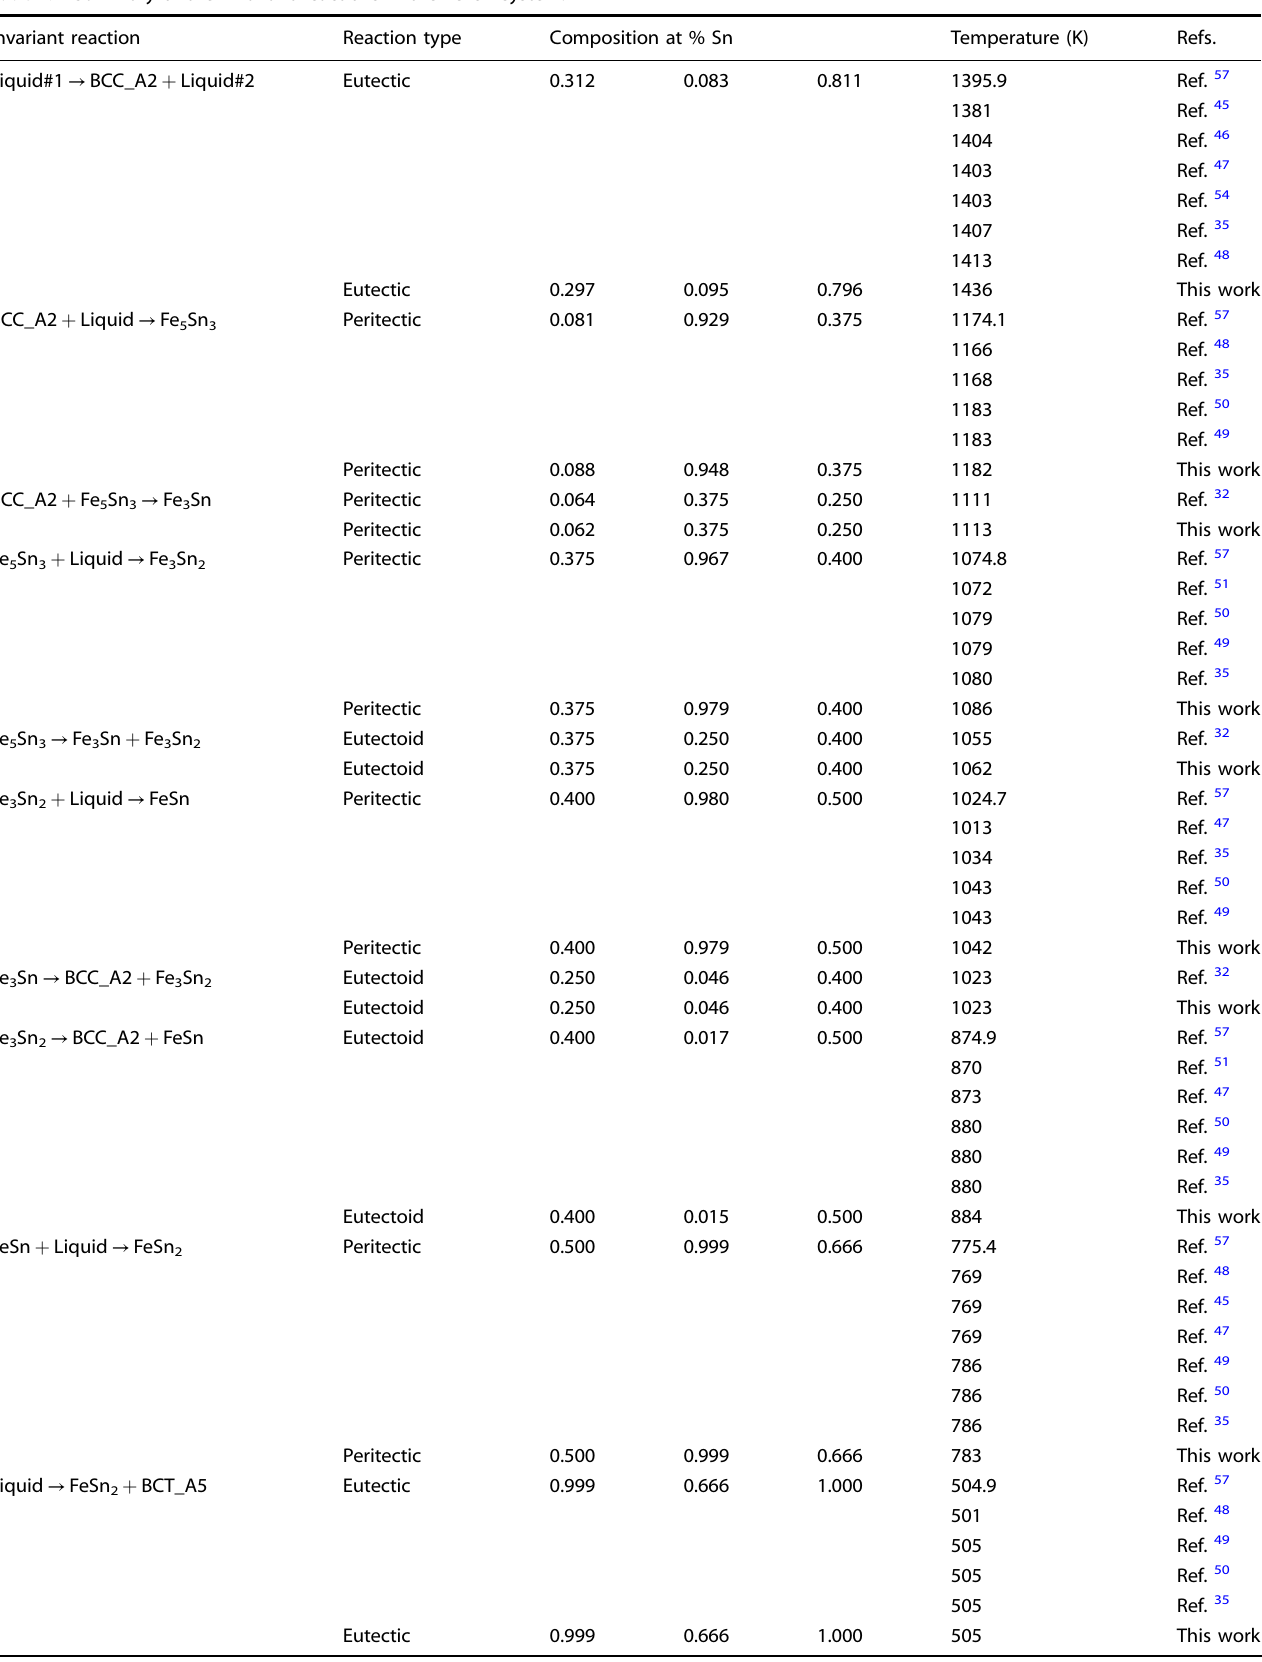
Table 2. Summary of the invariant reactions in the Fe – Sn system. Invariant